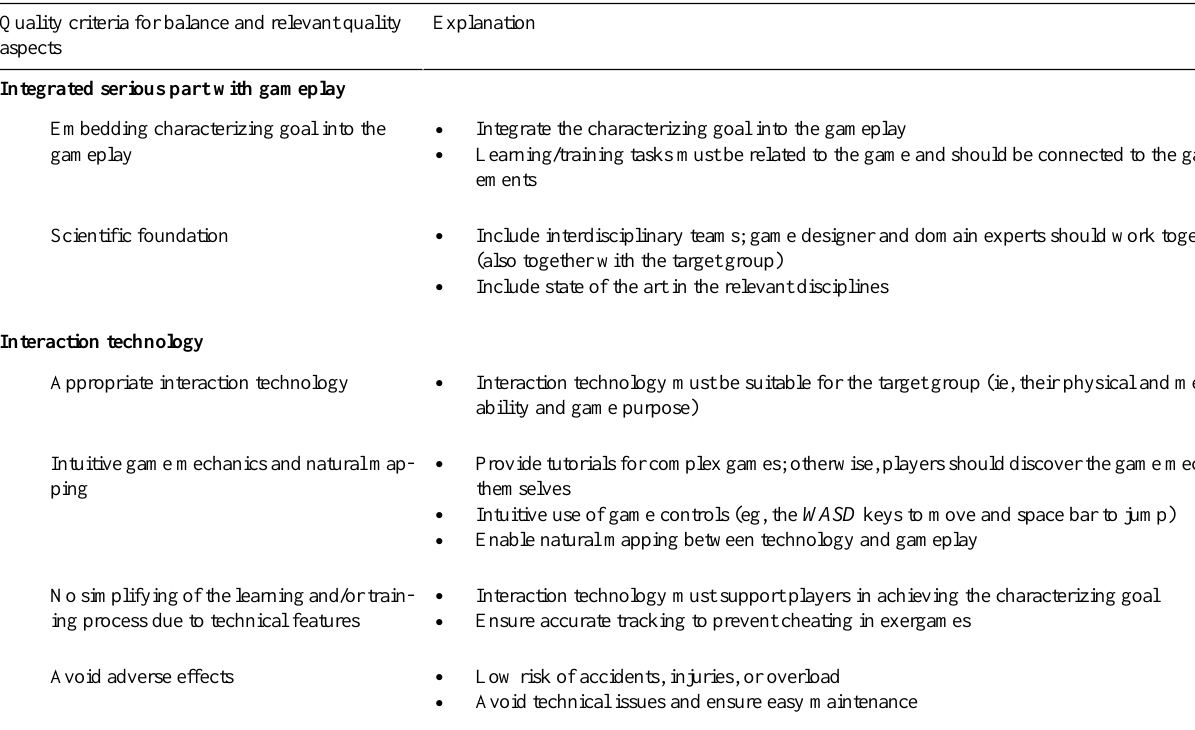
Table 3. Summary of quality criteria for balance between the serious and game part. ExplanationQuality criteria for balance and relevant